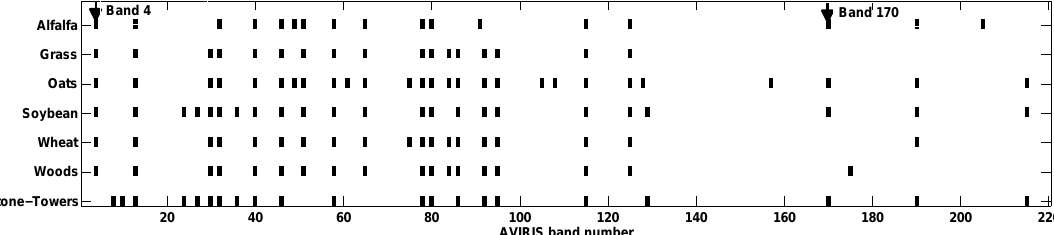
Figure 8. Illustration of the selected absorption features (black blocks), seven classes of vegetation in AVIRIS 92AV3C dataset.